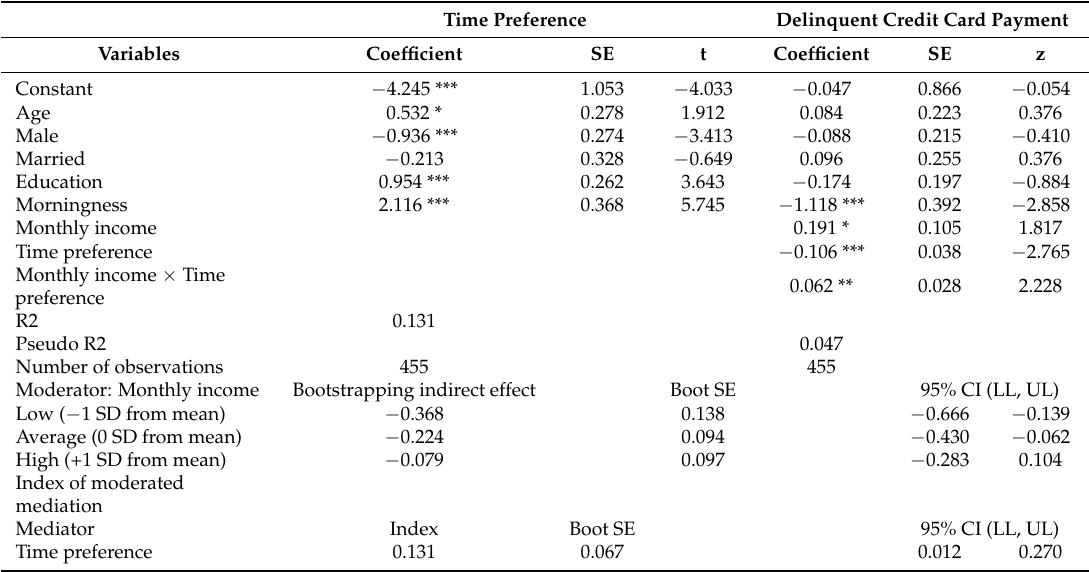
Table 6. The conditional indirect effect of morningness on delinquent credit card